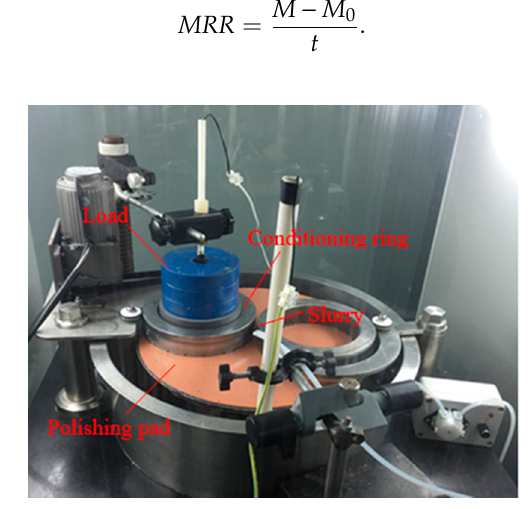
Figure 11. Actual polishing scene of DEPP. Table 1. Experimental conditions.